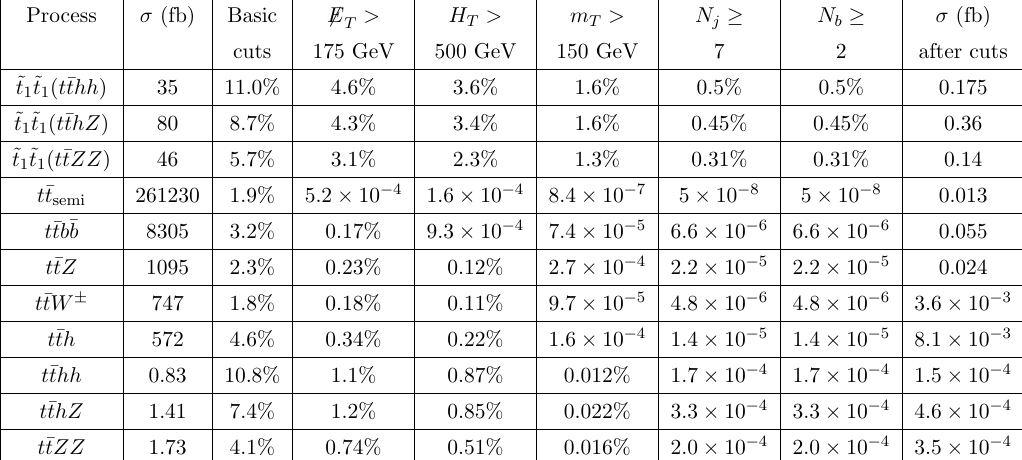
Table 5 . Cumulative cut e(cid:14)ciencies after each level of cuts and the (cid:12)nal cross sections for the t (cid:22) thh E E E signal ~ t 1 ~ t (cid:3) , t (cid:22) thZ and t (cid:22) tZZ , as well as SM backgrounds for 1 ‘ signal region for T T T 1 ! 6 6 6